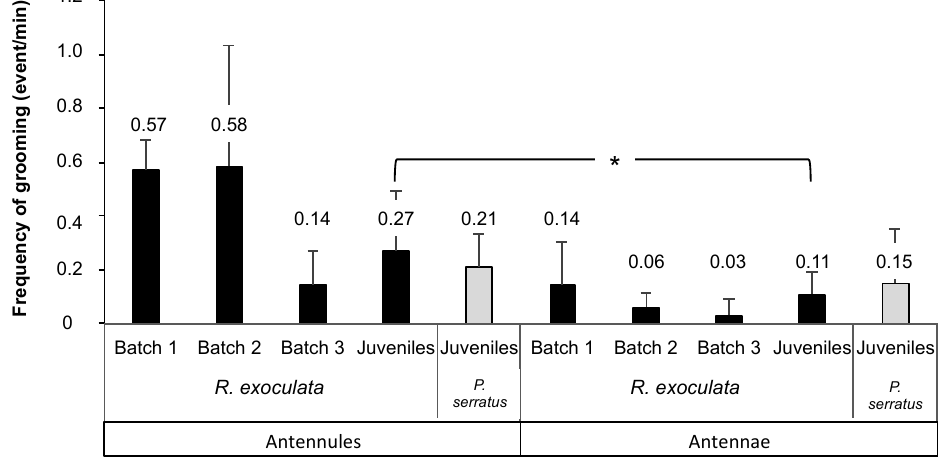
Figure 6. Frequency of grooming behavior of olfactory appendages in Rimicaris exoculata and Palaemon serratus . Frequencies are expressed as the number of grooming events per min (mean ± S.D.) for each batch of individuals for adult specimens of R. exoculata ( n = 3) and for the 3 batches of individuals for juveniles of P. serratus ( n = 9). The observations were carried out over a period of 53 min for each batch, and observations for the 3 batches of P. serratus juveniles were pooled, therefore corresponding to a total observation time of 159 min. For R. exoculata juveniles ( n = 8), 9 observations were carried out over a period of approximately 17 min on randomly chosen individuals, corresponding to a total observation time of 153 min. The experimental conditions are as follows: (1) R. exoculata adult batch 1: direct observation, 23 MPa, 10 ◦ C; (2) R. exoculata adult batch 2: 7 h maintenance before observation, 30 MPa, 20 ◦ C; (3) R. exoculata adult batch 3: 48 h maintenance before observation, 30 MPa, 10 ◦